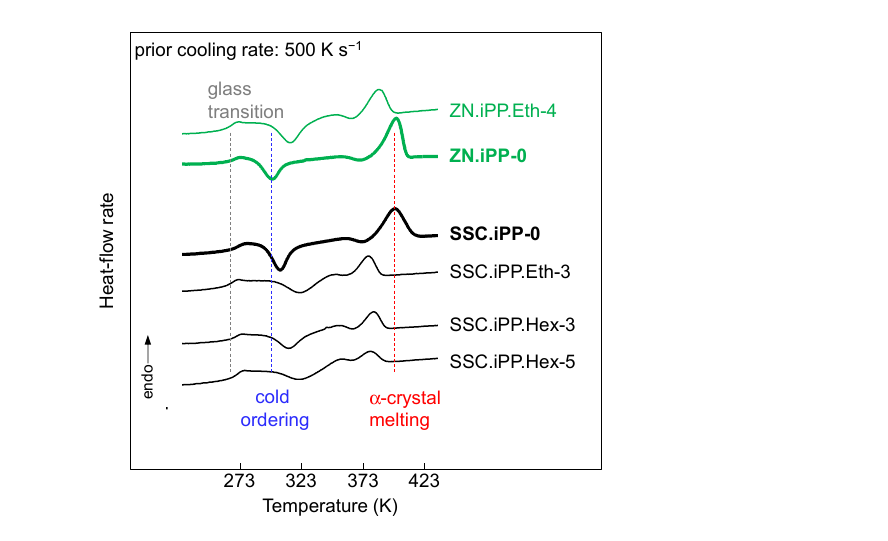
Figure 5. Heat-flow rate as a function of temperature collected on heating ZNC-based (green) and SSC-based (black) polypropylenes, cooled at 500 K/s. The vertical dashed lines indicate phase transitions of the ZN.iPP-0 homopolymer.